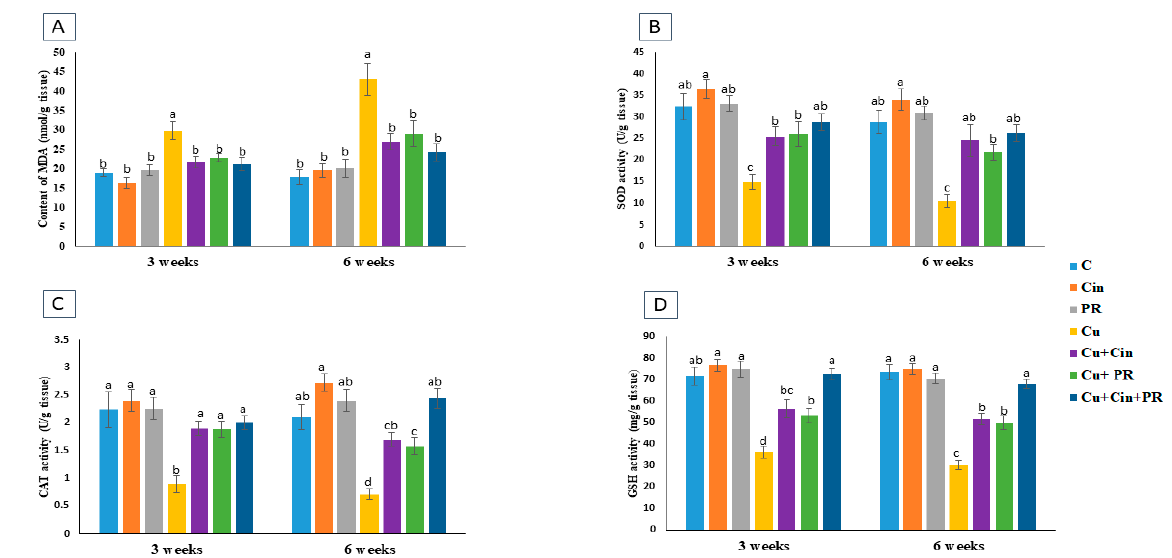
Figure 3. The effect of cinnamon and/or probiotic treatment on renal tissue lipid peroxidation and activities of antioxidant enzymes in copper intoxicated chickens: ( A ) The MDA content, ( B ) the SOD activity, ( C ) the CAT activity, and ( D ) the concentration of GSH. Data are expressed as mean ± SEM ( n = 5 chickens). Each bar carrying different letters is significantly different ( p < 0.05). C, control; Cin, cinnamon extract; PR, probiotic; Cu, copper.